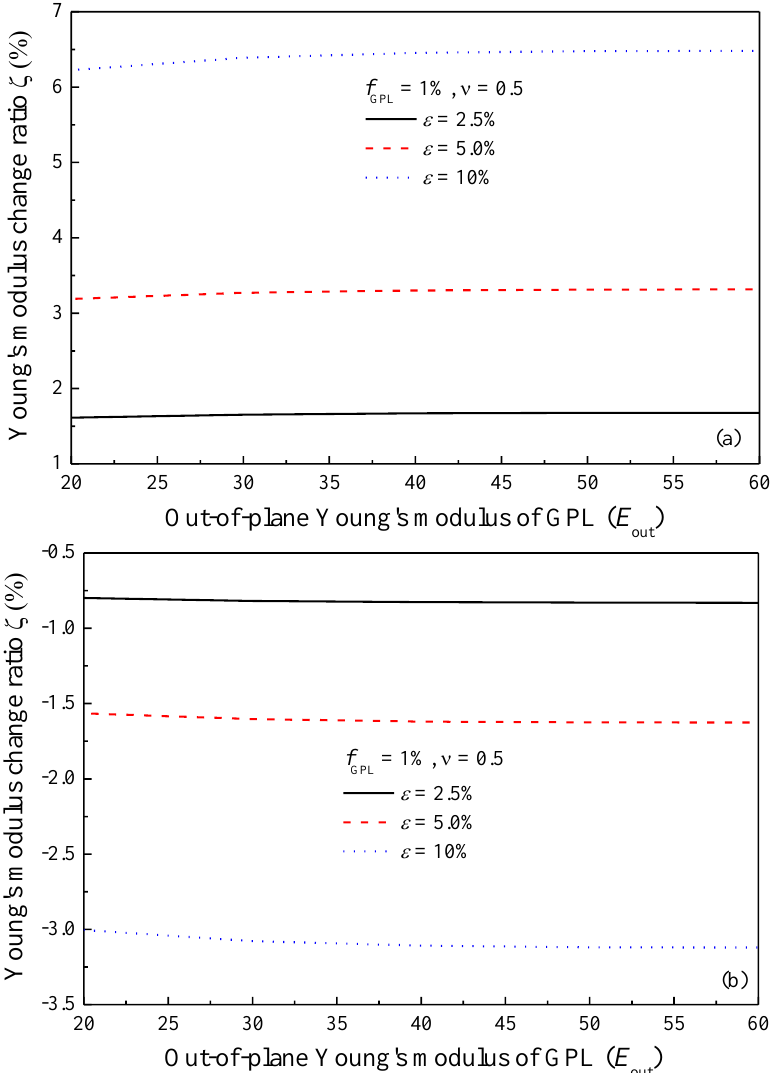
Figure 4. Effect of out-of-plane Young’s modulus of GPL ( a ) stretching direction; ( b ) transverse direction.